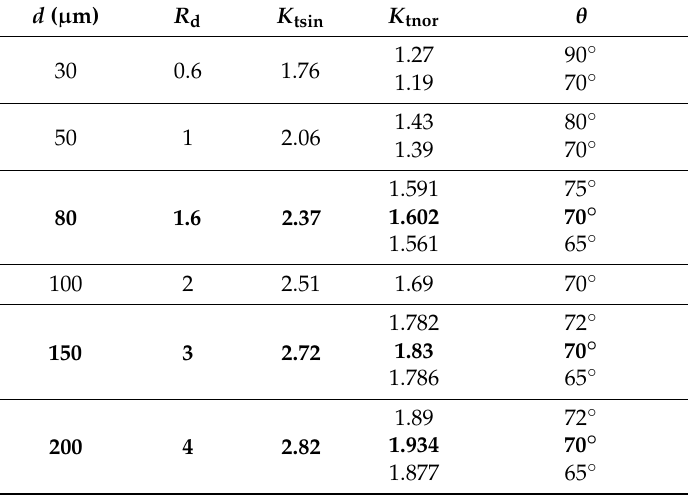
Table 4. The variation of K tnor and θ cri with the pit depths for double adjacent pits when λ = 1.1. The supplementary results are listed in bold.